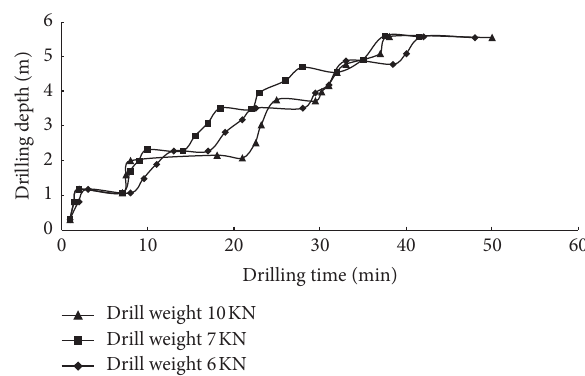
Figure 7: Relationship of drilling time and drilling